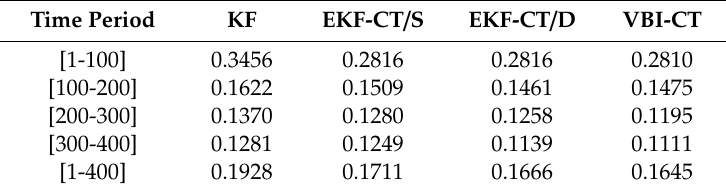
Table 2. Comparison of tracking error of di ff erent algorithms with σ 2 = 0.2.